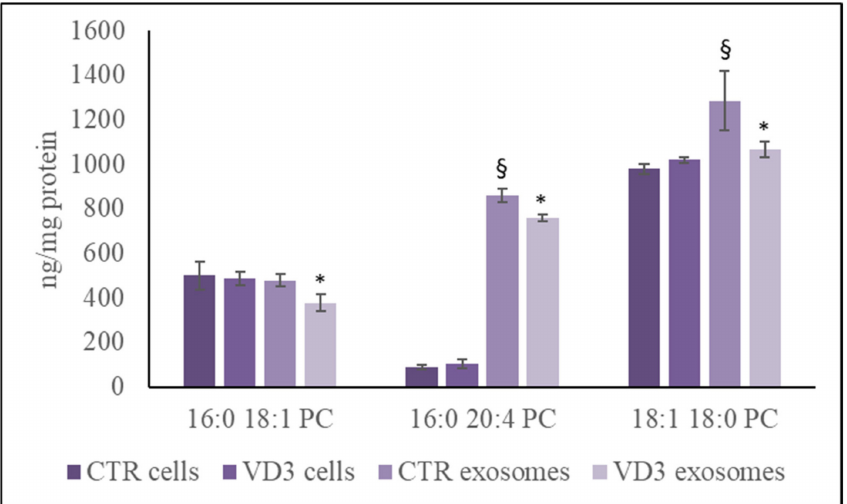
Figure 5. UFLC MS/MS analysis of phosphatidylcholine species in cells and exosomes. The analysis was performed as reported in the Section 4. Data are expressed as nmol/mg protein. Data represent the mean ± SD of three independent experiments performed in duplicate (case number: 6). * p < 0.05 versus the control sample, § p < 0.05 versus cells PC, phosphatidylcholine; CTR, control sample; VD3, vitamin D3